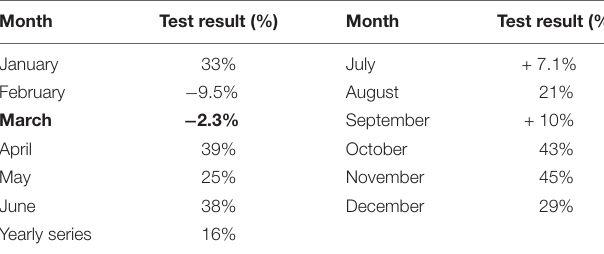
TABLE 2 | Comparison between 1976–2000 and 1951–1975 by Wilkoxon–Mann–Whitney